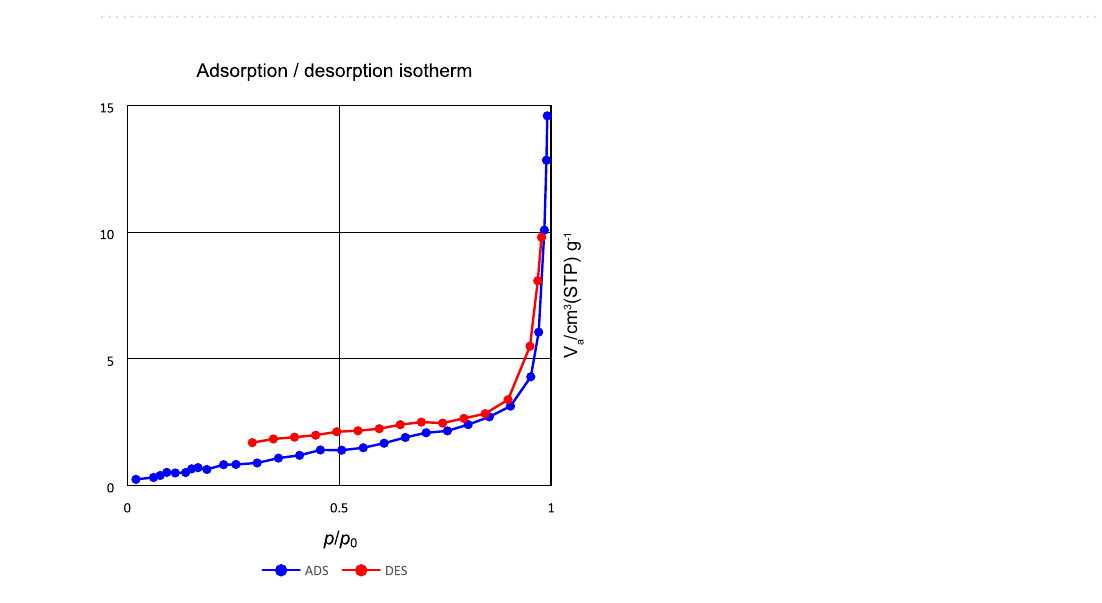
Figure 7. N 2 adsorption/desorption isotherms of the